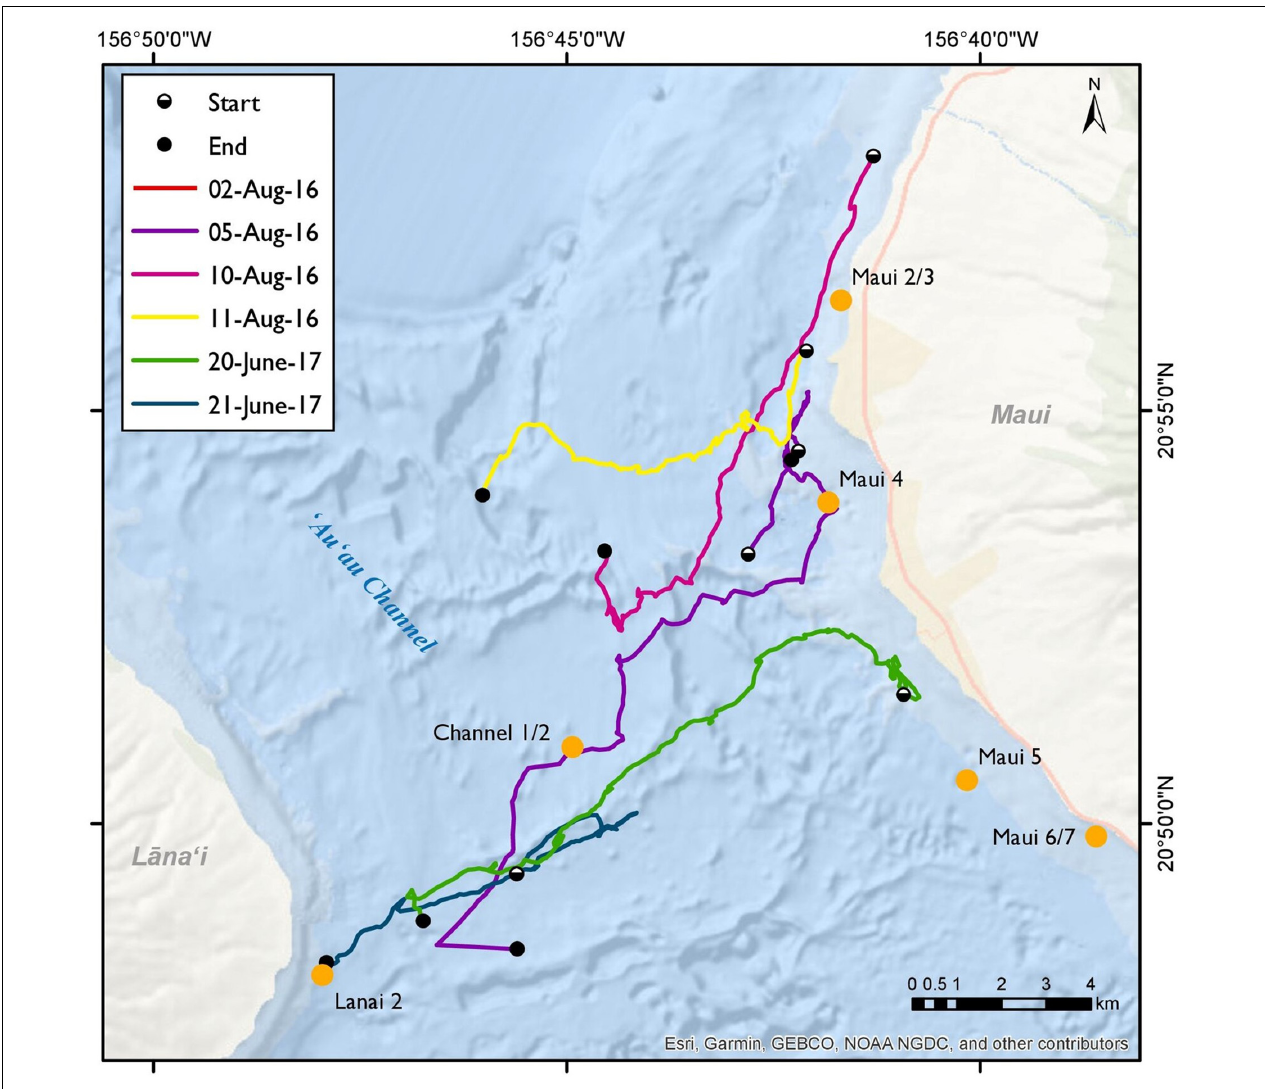
FIGURE 7 | Spinner dolphin sightings from vessel surveys on the 2nd, 5th, 10th, and 11th of August 2016, and the 20th and 21st of June 2017 in the Maui Nui region. The beginnings and endings of sightings are indicated by white dots and black dots, respectively. Ecological Acoustic Recorder (EAR) locations are marked by orange